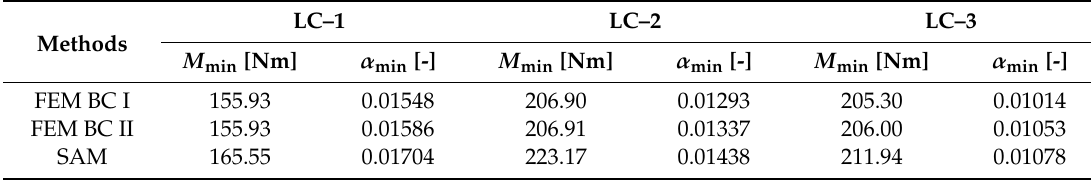
Table 5. Comparison of buckling moment and angle of